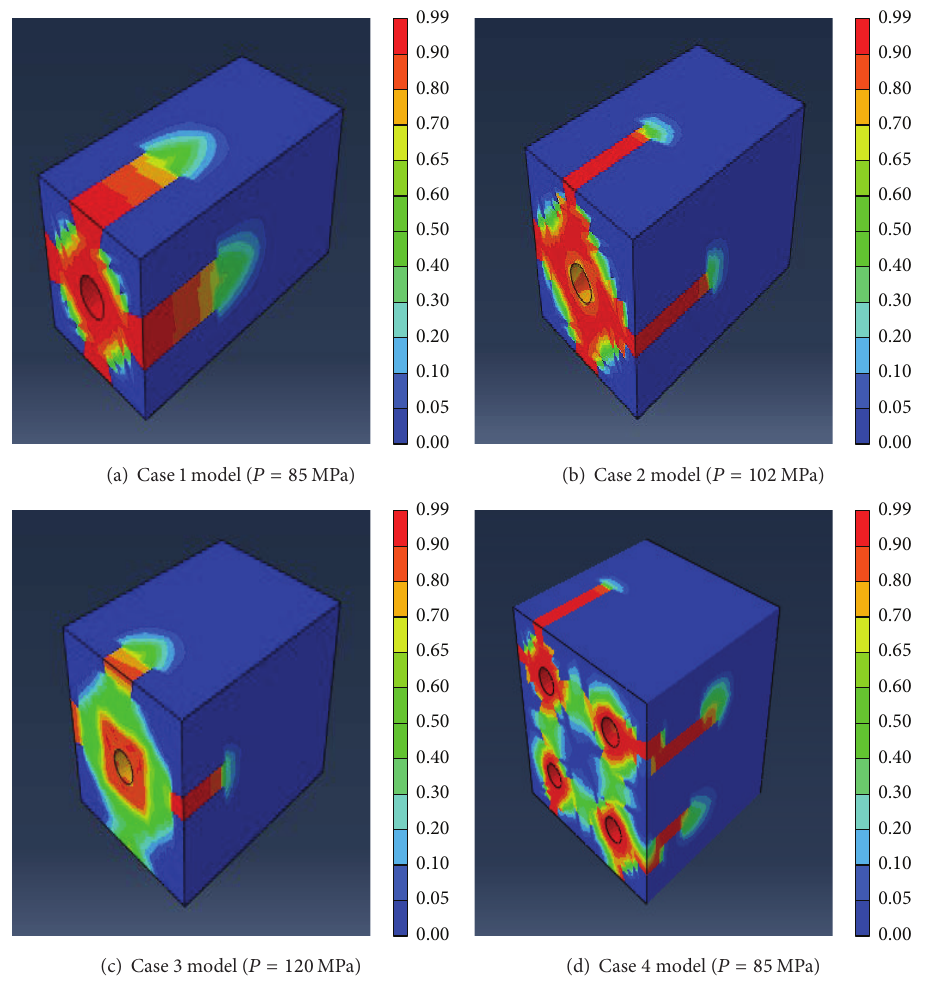
Figure 14: Probability of cracking occurrence determined based on excessive tension